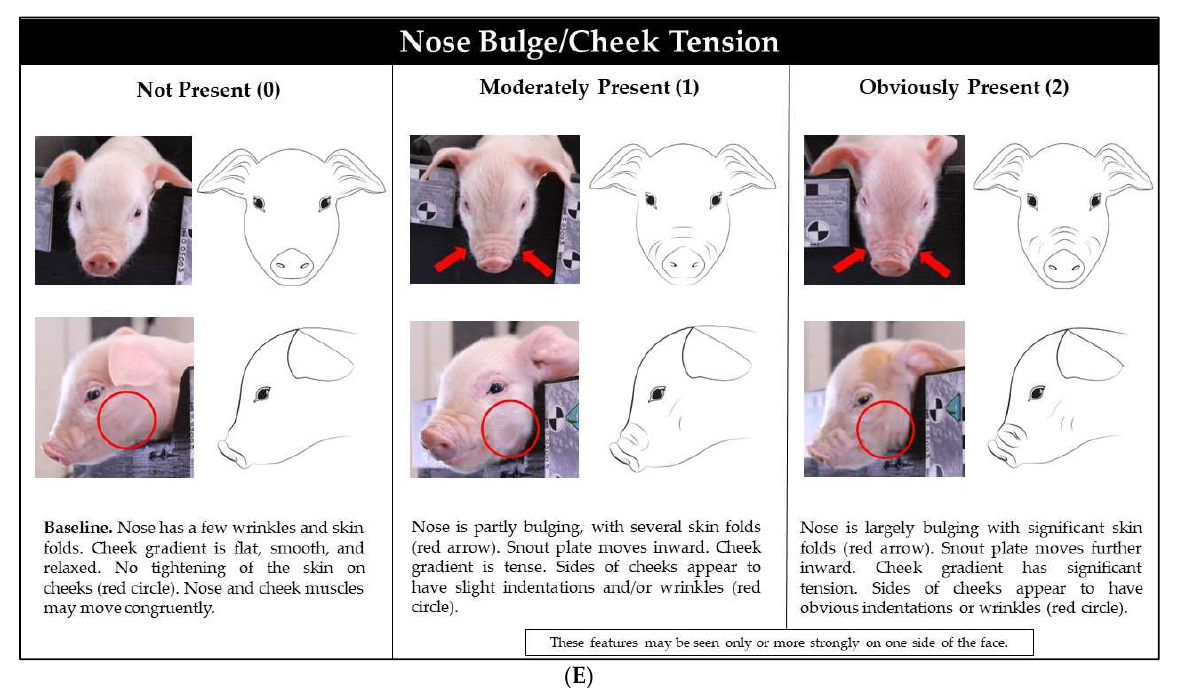
Figure 3. The Piglet Grimace Scale, a pictorial diagram of each facial action unit. Each facial action unit except lip contraction was scored on a 3-point scale (0 = Not Present, 1 = Moderately Present, and 2 = Obviously Present). Lip contraction was scored on a 2-point scale (0 = Not Present and 1 = Present). Grimace sketches were designed by Richard, C. (2020). Orbital tightening, ear position, temporal tension, lip contraction, and nose bulge/cheek tension digital illustrations. Digital Content